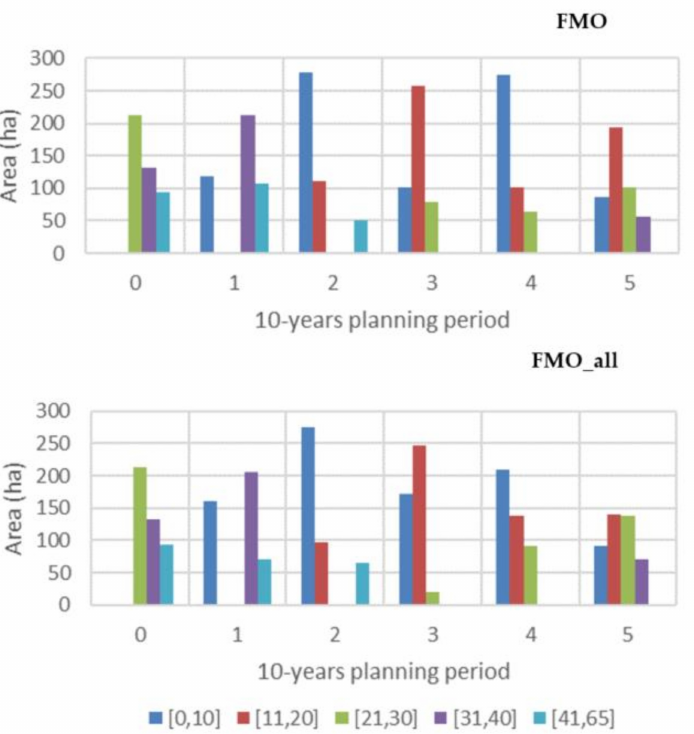
Figure 5. Area by age class during the planning horizon according to the results of model FMO and FMO_all.